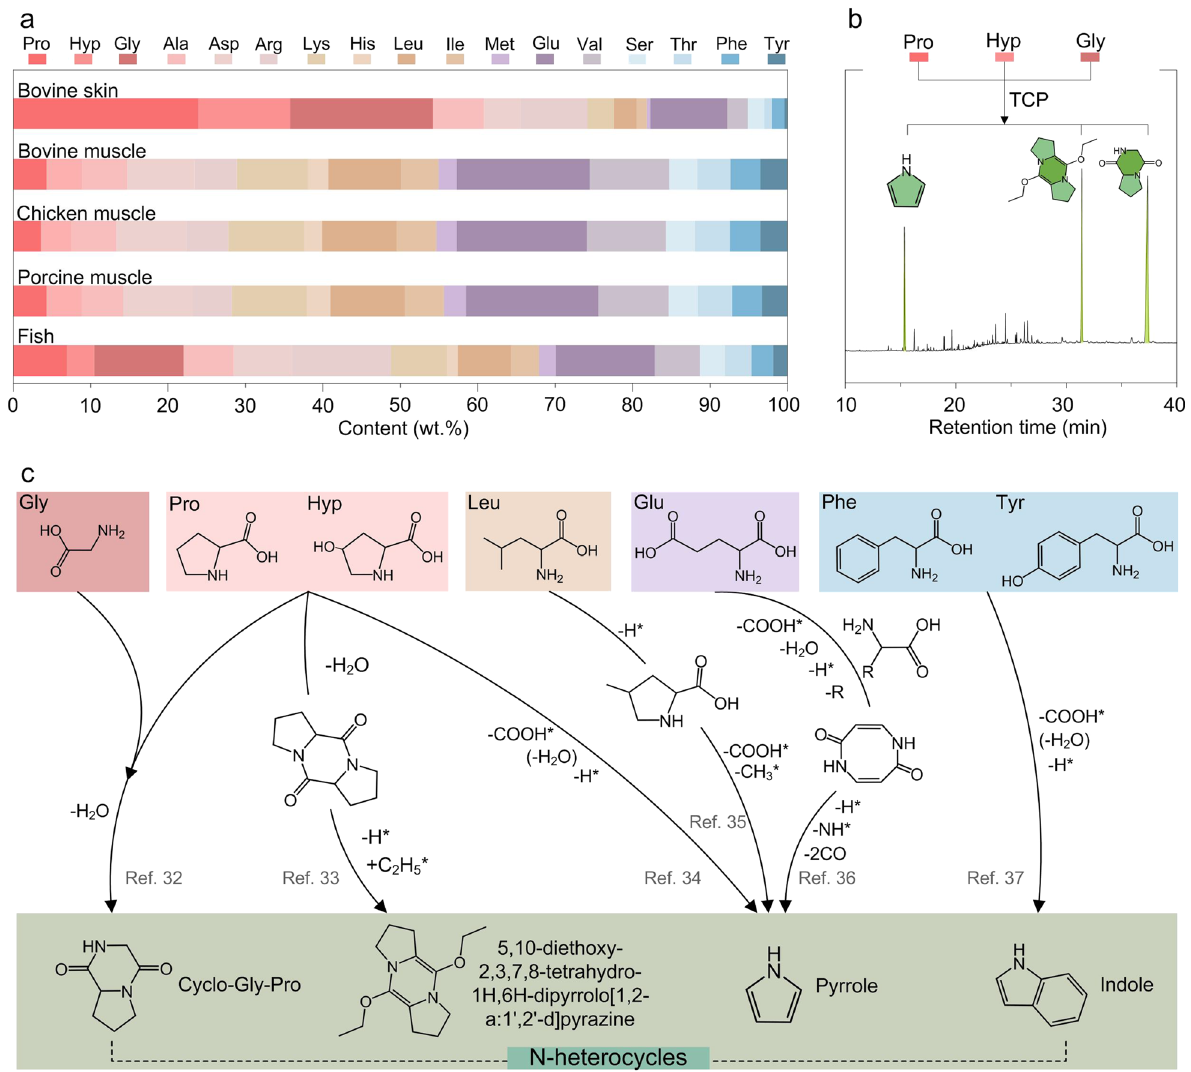
Fig. 3 Nitrogen transformation from the animal biomass into main N-heterocycles. a The contents of the amino acids in the animal biomass. b GC–MS spectrum of the products in bio-oil after TCP of the mixture of glycine, proline, and l -hydroxyproline. c Proposed mechanism of nitrogen transformation from amino acids into the